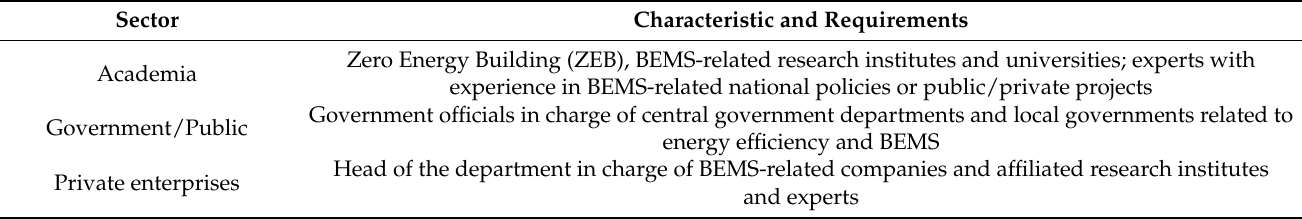
Table 2. Expert groups selected for the